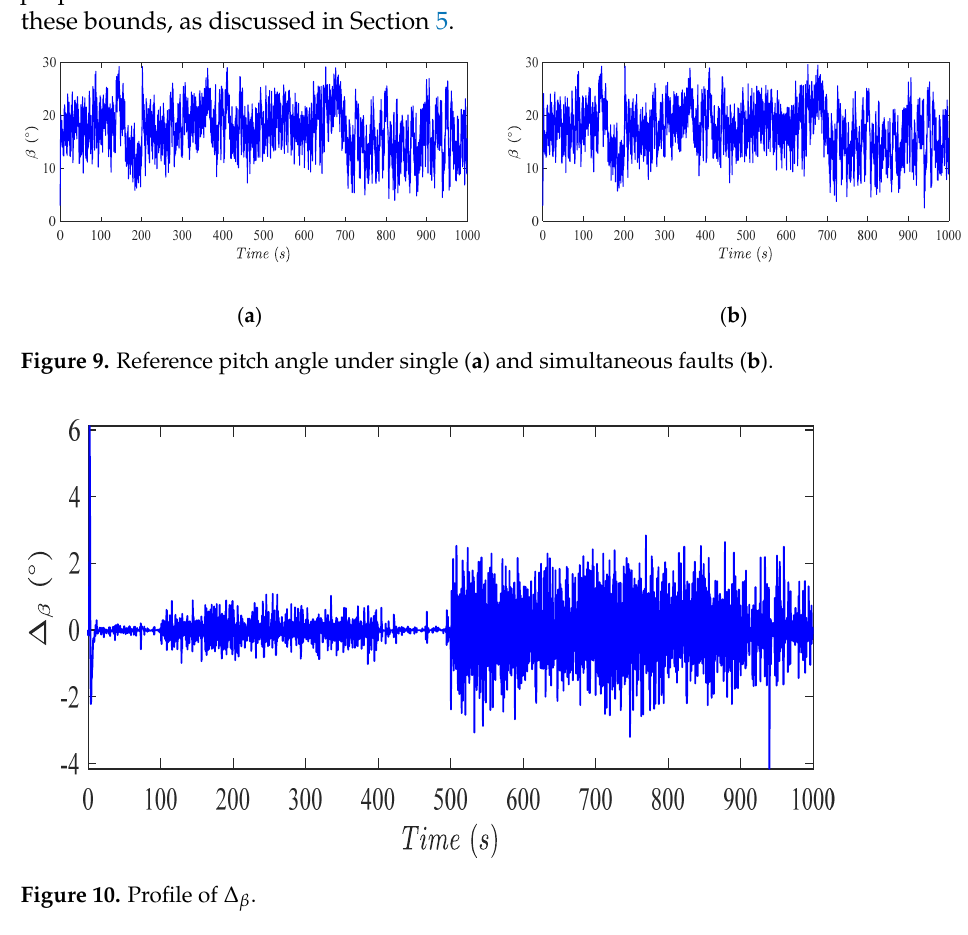
Figure 8. Generated power 𝑃 (cid:3034) (blue line) with constructed constraints (red dashed lines) and nominal value (green dashed line), under single ( a ) and simultaneous faults ( b ).